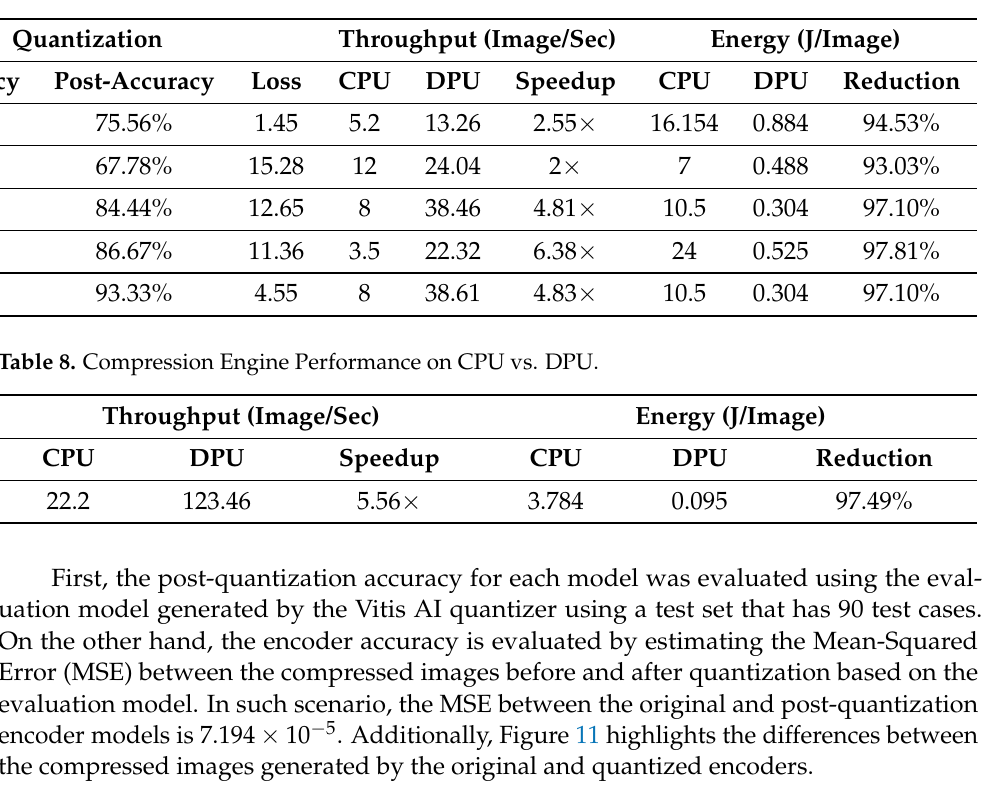
Table 7. Classifiers Implementation parameters.